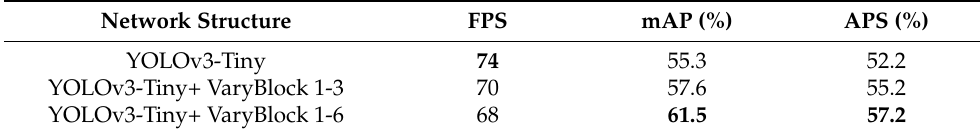
Table 5. The test results with different layers add VaryBlock.